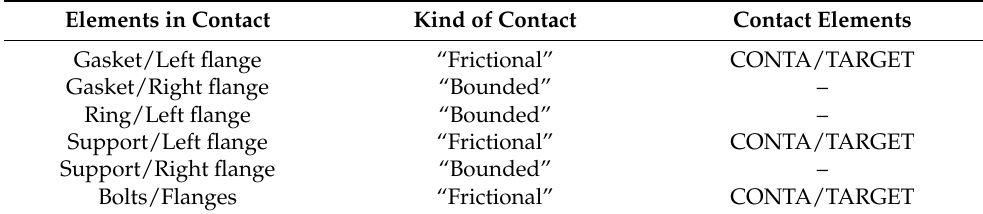
Figure 9. Contact surfaces and kind of contact between the elements of the model. The coefficient of friction on the bearing surface of the flanges with the nut and bolt head surface was assumed as 0.15, whereas, in the case of the face contact surface of the gasket with the flange-raised face, the value was assumed as 0.4. The “BOUNDED”-type contact was used on the contact surface of the gasket with the right flange-raised face. The contact ensured bonding of the gasket with the flange, preventing the “escape” of the gasket at the pipeline bending. The types of contact defined between particular elements are presented in Table 3. Table 3. Types of contact for individual interacting elements of the